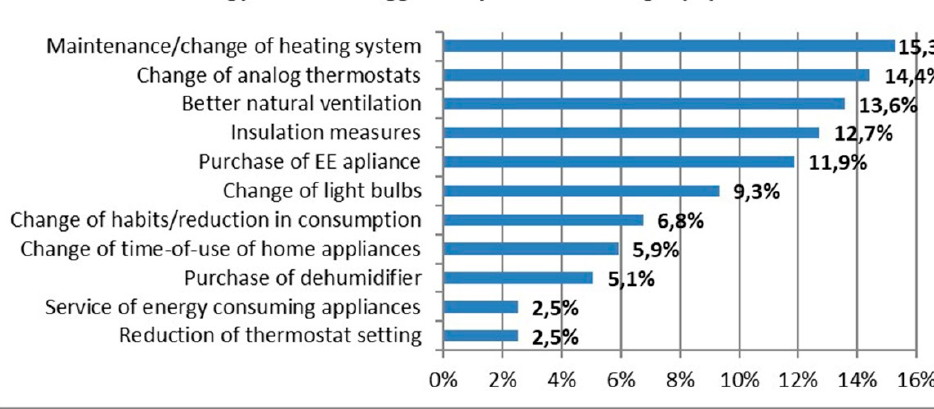
Figure 10. Energy decisions triggered by the monitoring equipment.